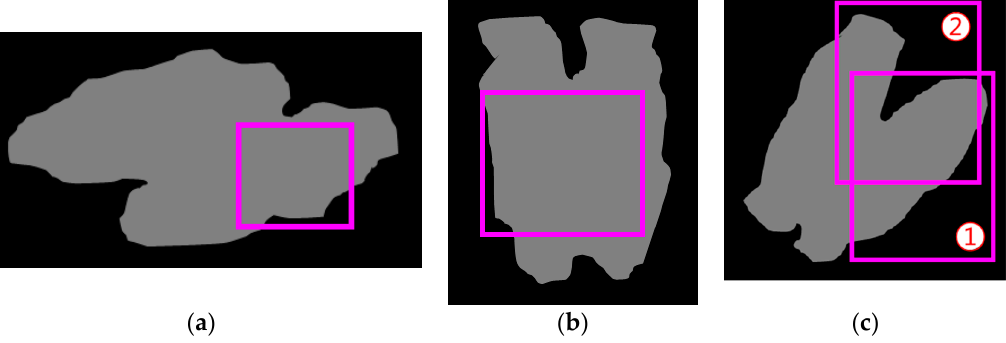
Figure 6. Illustration of the BB size, boundary, and coverage conditions: ( a ) the BB is not satisfied as useful according to the BB size condition; ( b ) the BB cannot be a useful BB, because it satisfies the BB size condition, but